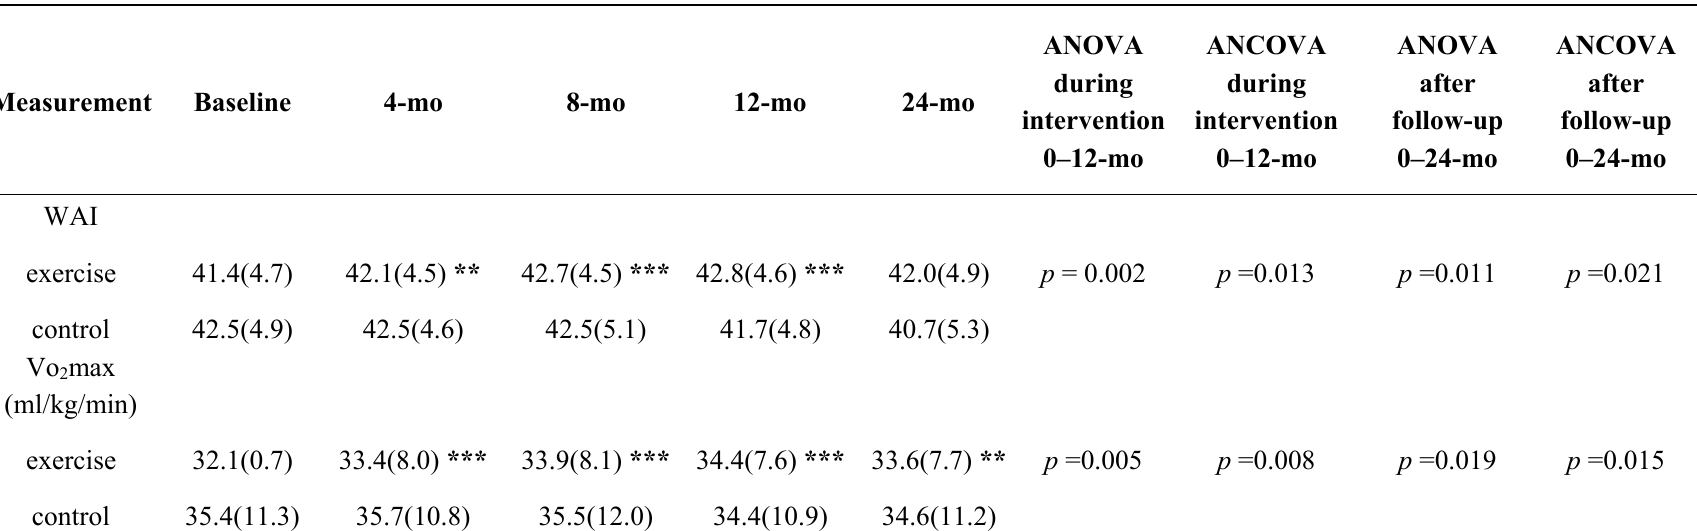
Table 2. Work ability index (WAI) and Vo max (ml/kg/min) trial * group (intervention/control) interaction in exercise intervention group 2 ( n = 338) and control group ( n = 33), during exercise intervention (baseline (0 months), 4-, 8- and 12-months) and follow-up (24-months). The ANCOVA model contains age, sex, and BMI as